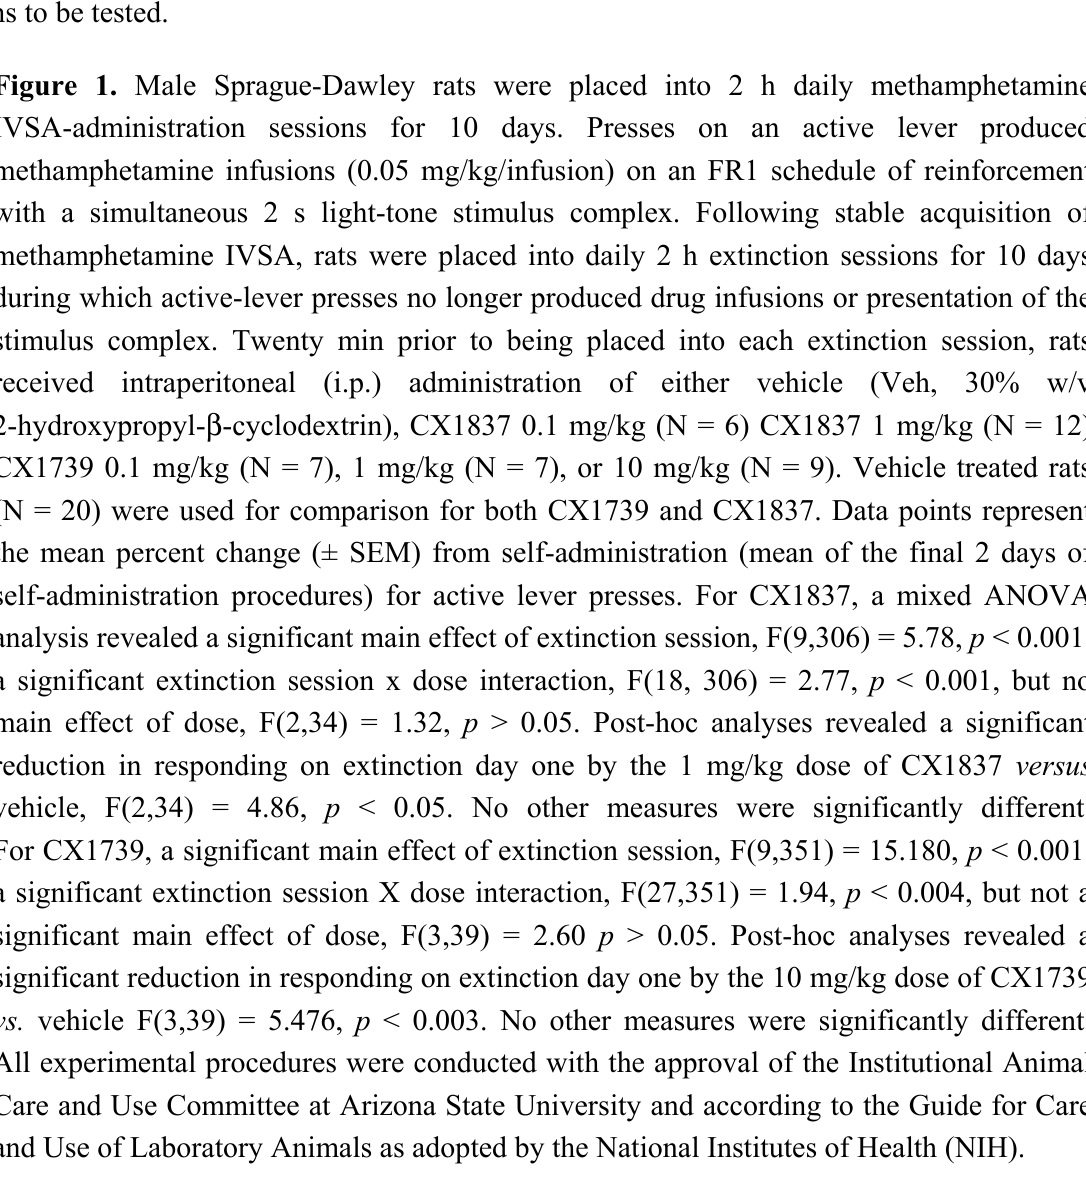
Figure 1. Male Sprague-Dawley rats were placed into 2 h daily